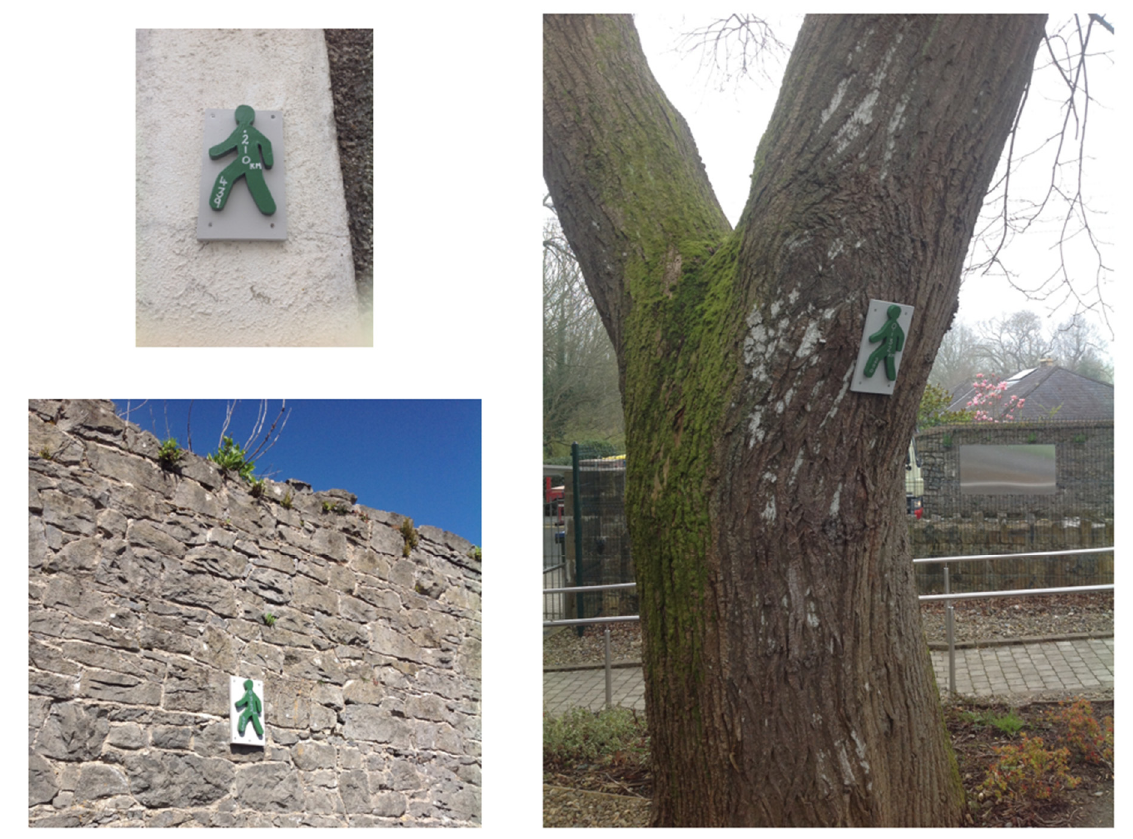
Figure 3. Walking path markers.